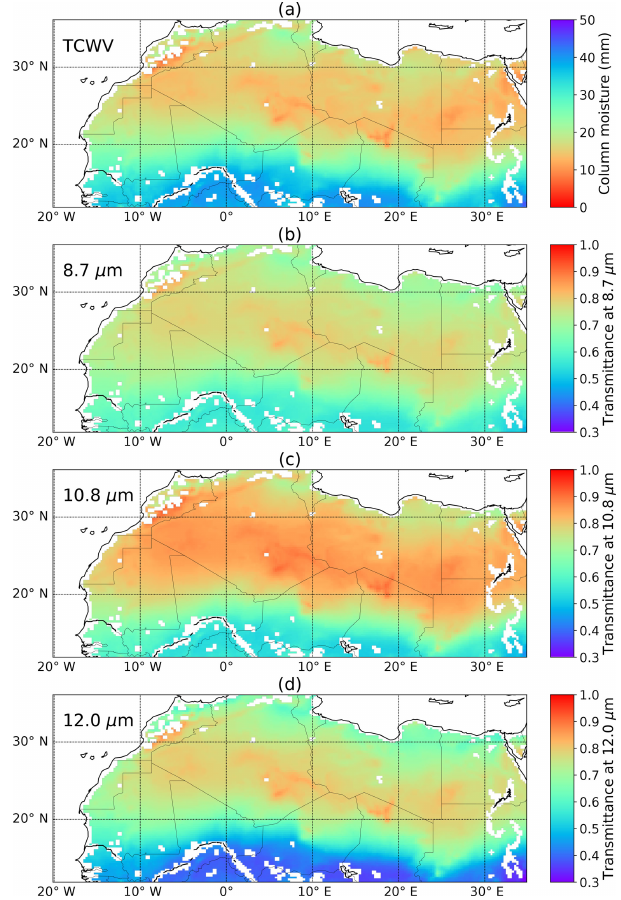
Figure 3. Maps of mean atmospheric properties simulated by COSMO-MUSCAT-RTTOV, June and July 2011–2013, for all eight time slots during the diurnal cycle. (a) Column moisture (mm) and (b, c, d) pristine-sky atmospheric transmittances at 8.7, 10.8, and 12.0µm. As with Fig. 2, these averages are only made using points where and when RTTOV simulations have been performed.